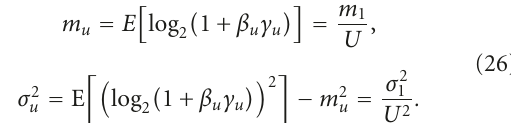
for 10 symbols user 1 can transmit 0 . 5 bits/symbol, user 2, 0 . 7 bits/symbol, and user 3, 1 . 1